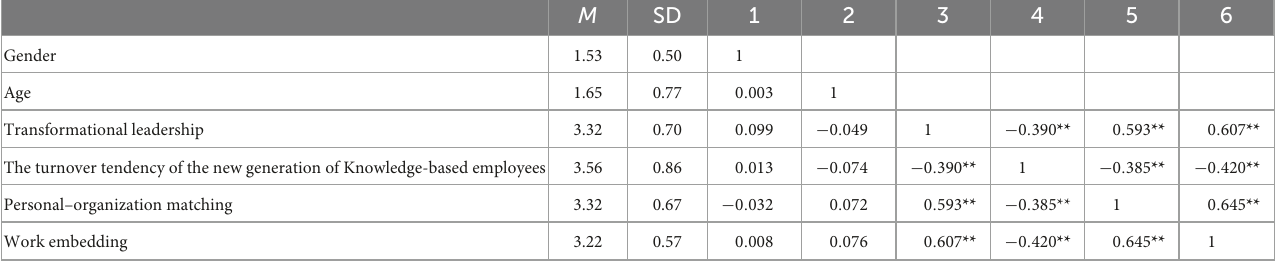
TABLE 4 Descriptive statistics and correlation analysis ( N =